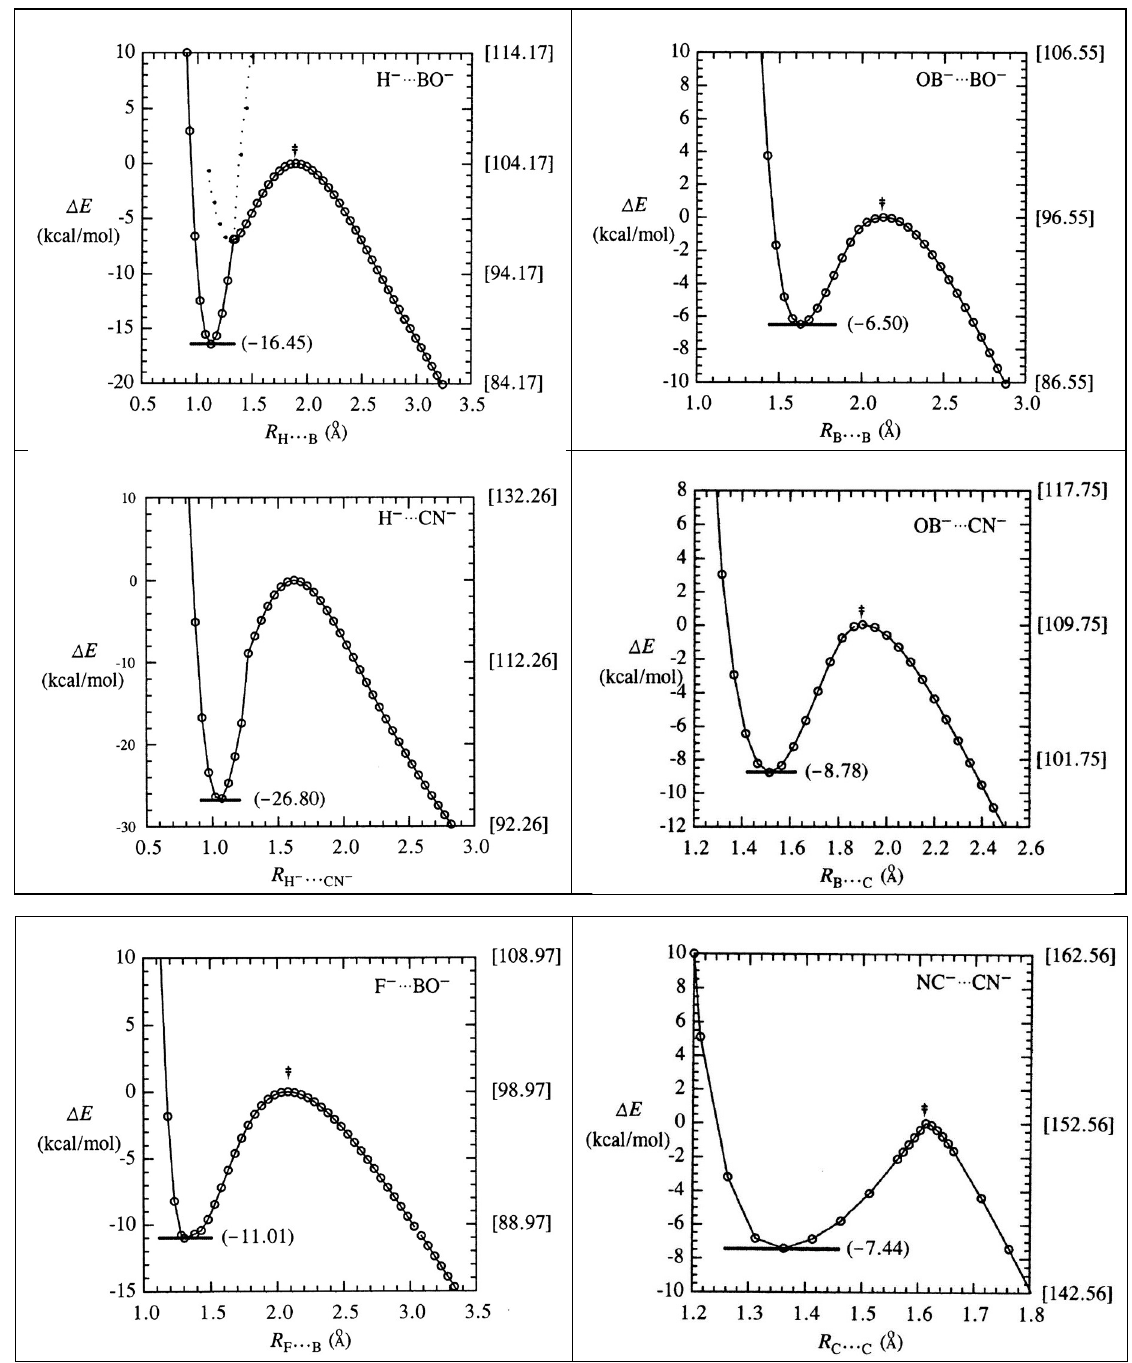
Figure 3. Relaxed-scan energy profiles for metastable binding wells of the six pihole complexes of Figure 1, showing the parenthesized well depths ( left scale) and bracketed dissociation energies ( right scale) to the long-range dissociation limit.